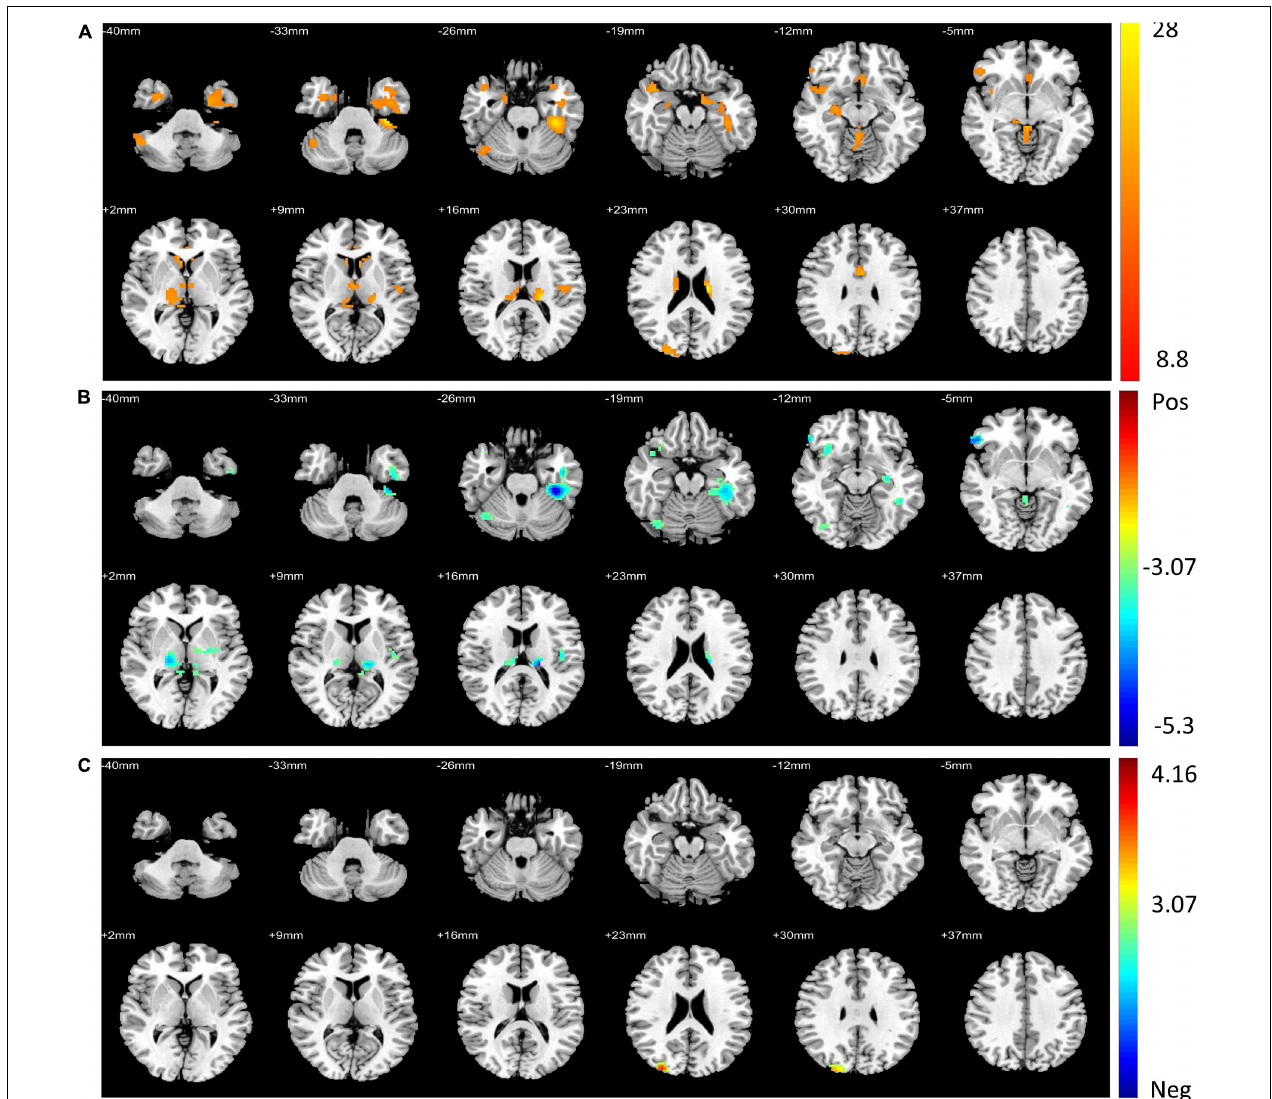
FIGURE 1 | Regions with significant differences in voxel-wise functional connectivity (FC) temporal variability between post- and pre-repeated transcranial magnetic stimulation (pre-rTMS) interventions. (A) Regions with significant treatment and time interaction effects in repeated measures ANCOVA. (B) The paired t -test of the TSZ group showed significant differences in post-repeated transcranial magnetic stimulation (post-rTMS) compared with pre-rTMS. (C) The paired t -test of the DSZ group showed significant differences between post- and pre-rTMS interventions. The threshold was set as p < 0.005 and volume > 600 mm 3